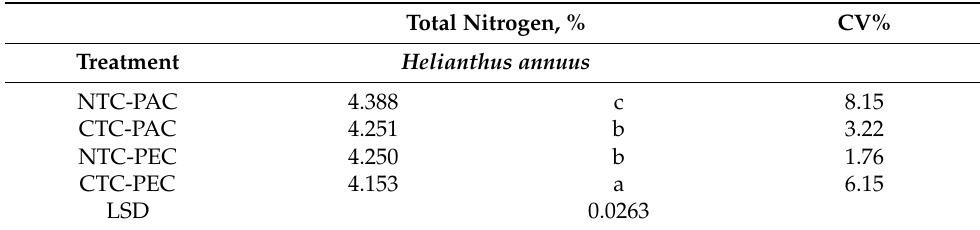
Table 1. Total nitrogen (%) of the Helianthus annuus cultivation for the 4 different soil practice treatments in the first growing year.